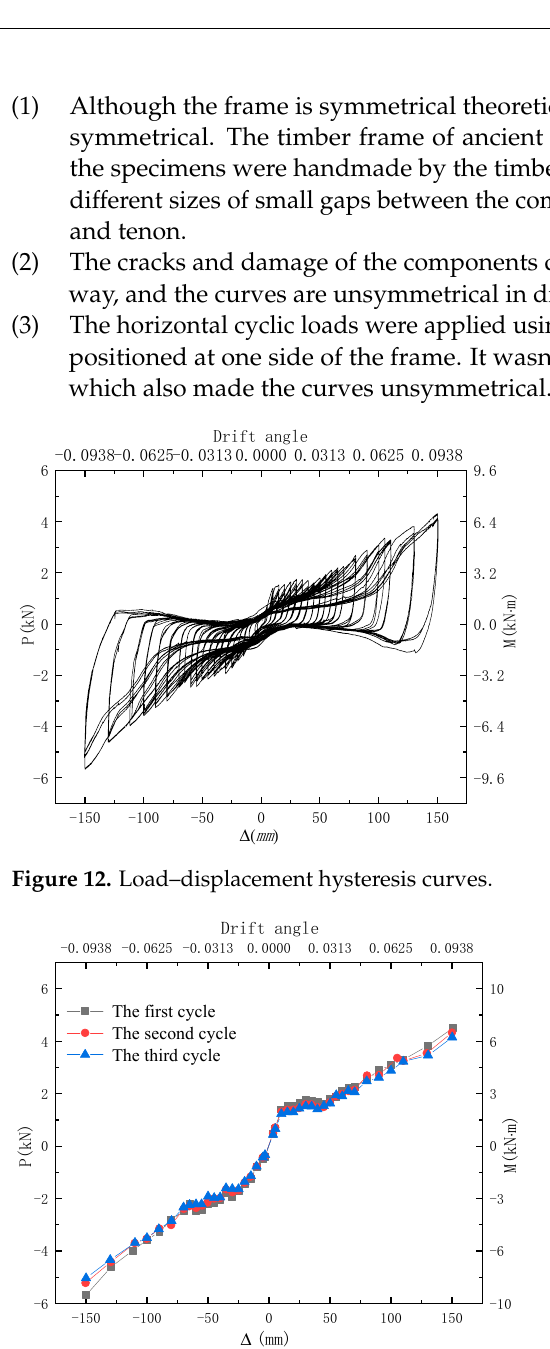
Figure 13. Load–displacement envelope curves.